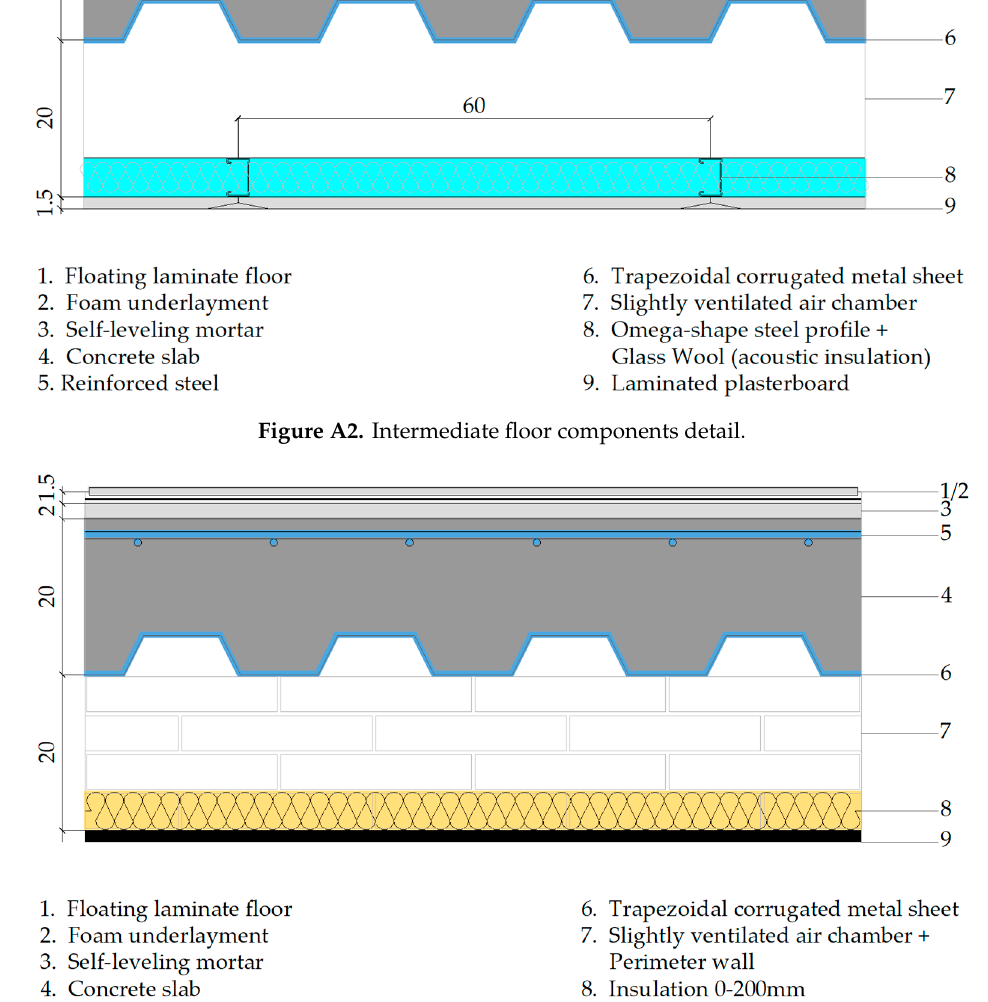
Figure A3. Ground floor components detail.